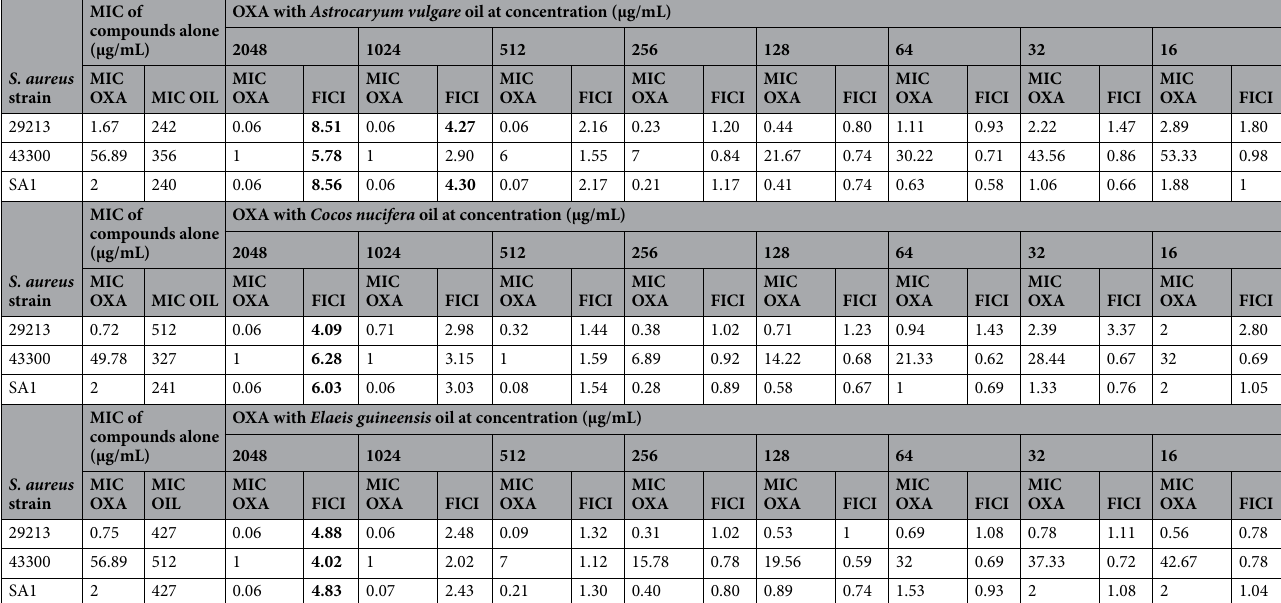
Table 2. Combinatory effect of crude palm seed oils and oxacillin against Staphylococcus aureus determined by checkerboard method. Data are presented as average of three analyses, each performed in triplicate.